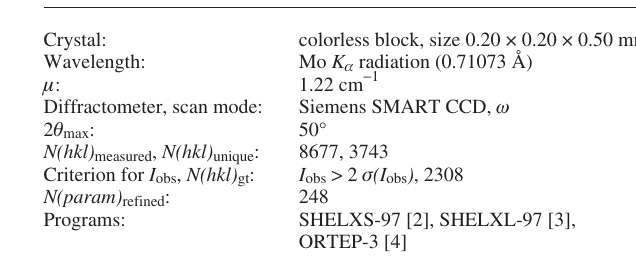
Table 1. Data collection and handling.